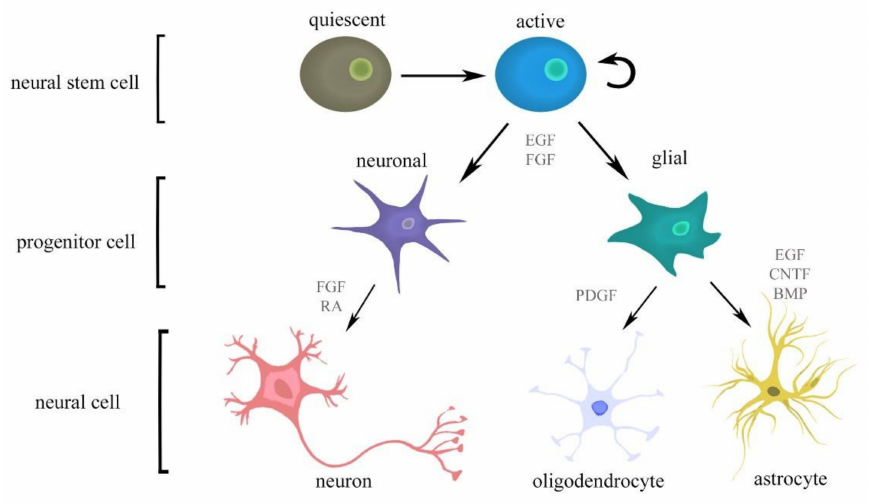
Figure 3. Activation and differentiation of NSC processes are controlled by multiple signalling molecules. Abbreviations: bone morphogenic proteins (BMPs), ciliary neurotrophic factor (CNTF), epidermal growth factor (EGF), fibroblast growth factor (FGF), platelet-derived growth factor (PDGF), and retinoic acid